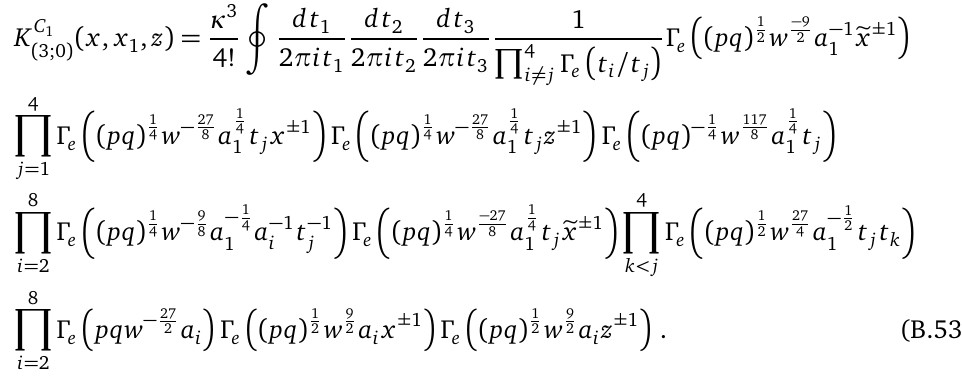
Figure 22: On this figure we show the chain of Seiberg dualities used in the derivation of the C trinion given in (B.53). On the Figure (a) we start with the S gluing of the C 1 trinion (3.30) with the tube (3.32) obtained by closing SU ( 2 ) no defect. Then we use Seiberg duality on the S-confining SU ( 2 ) gauge theory is shown on the Figure (b). After this we perform two Seiberg dualities on one and another gauge nodes one after another. In the end we arrive to the SU ( 4 ) gauge theory with 7 flavors, one antisymmetric and some singlets. Corresponding quiver is shown on the Figure